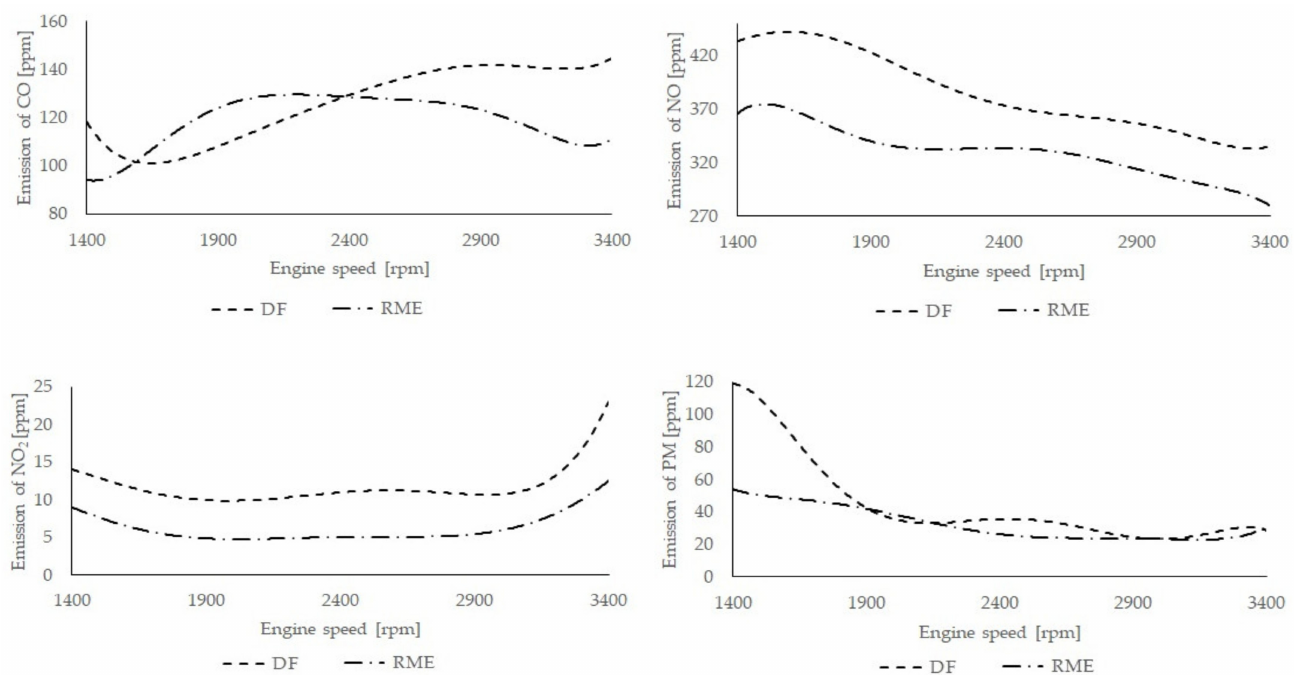
Figure 4. CO, NO, NO 2 , and PM emission (ppm) at full engine load as a function of rotational